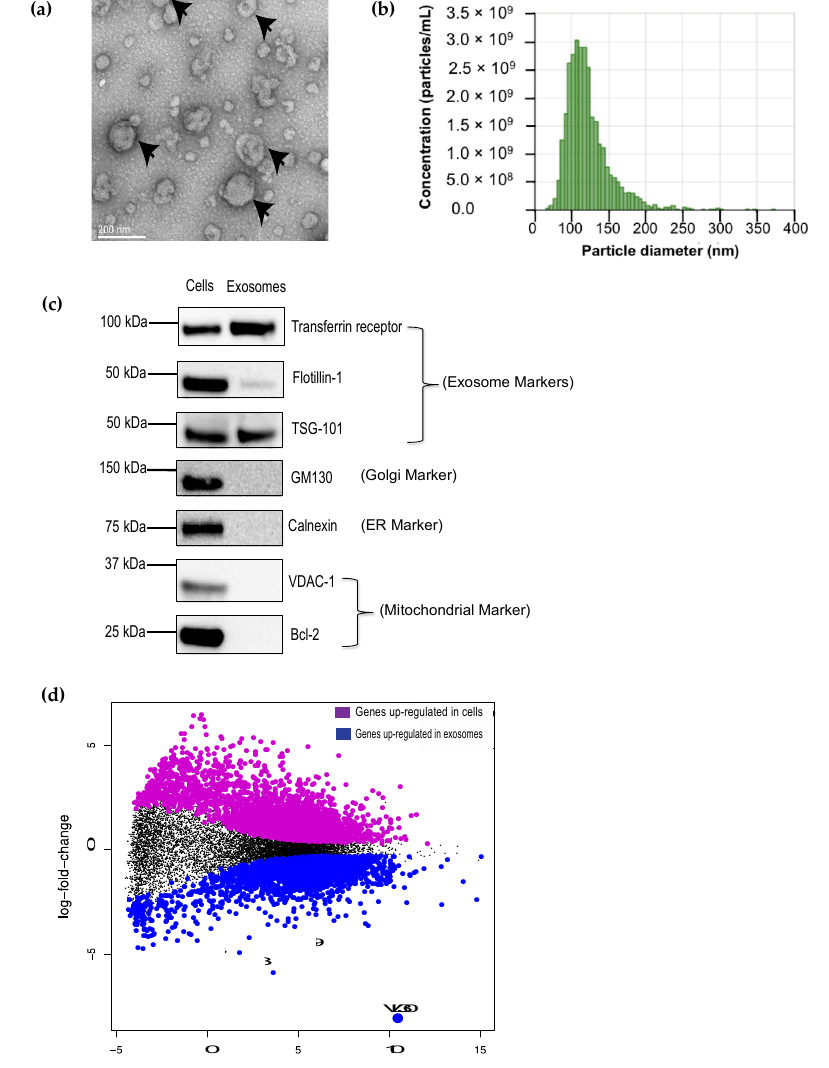
Figure 1. The VL30 RNA is enriched in DC SEVs. ( a ) DC SEVs (black arrows) display a typical appearance by transmission EM; scale bar = 200 µ m. ( b ) Size assessment of SEVs by qNano. Most vesicles fall within the size range expected for SEVs (60–140 nm). ( c ) Western blot analysis of classical SEV markers–transferrin receptor, flotillin-I and TSG-101–from cell and SEV DC lysates. GM130 (Golgi), Calnexin (ER), VDAC-1 and Bcl-2 (mitochondria) proteins were not detected in the DC SEVs indicating a lack of contamination by cell debris. Each lane loaded with 50 μ g protein. ( d ) MA plot showing the average log expression of each gene (horizontal axis) plotted against the log-fold change in gene expression between cells and SEVs (vertical axis), based on RNA sequencing of DCs and their SEVs (n = 6 each). Each dot in the graph represents one RNA. Transcripts that were differentially expressed between cells and SEVs were identified (adjusted p -value < 0.05; see Methods) and are shown either in magenta (upregulated in cells) or blue (upregulated in SEVs). The RNA that showed the greatest enrichment in SEVs (~200-fold) was VL30 (big blue dot).